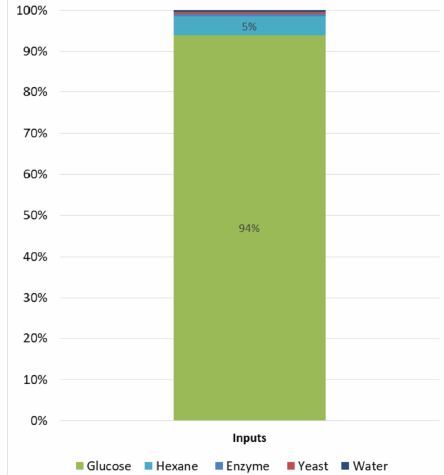
Figure 4. Share of each input category to the total input